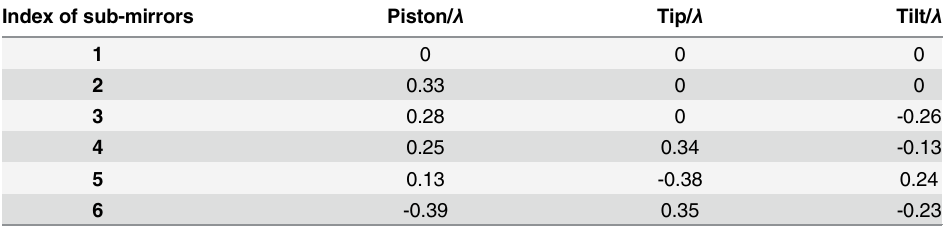
Table 1. A set of random co-phase errors for